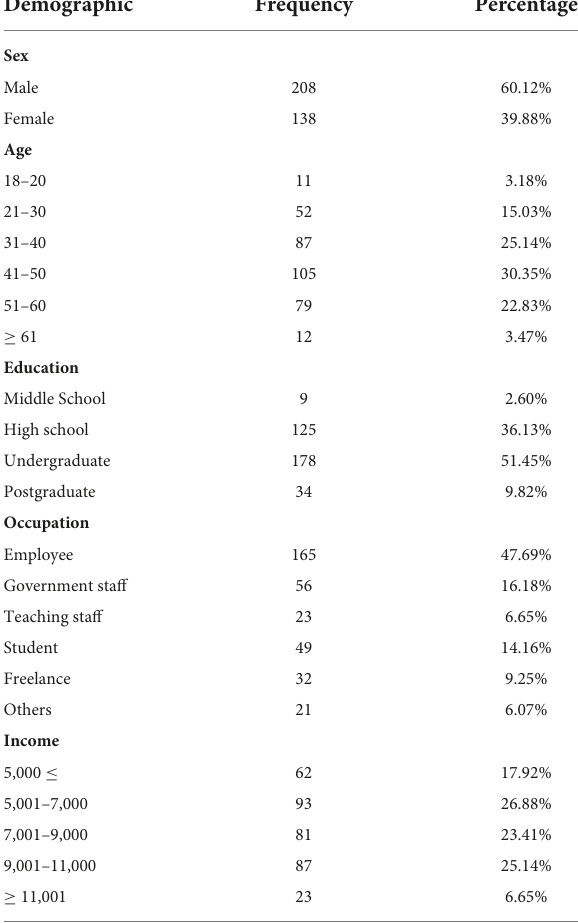
TABLE 1 Demographic profile of the sample ( n =